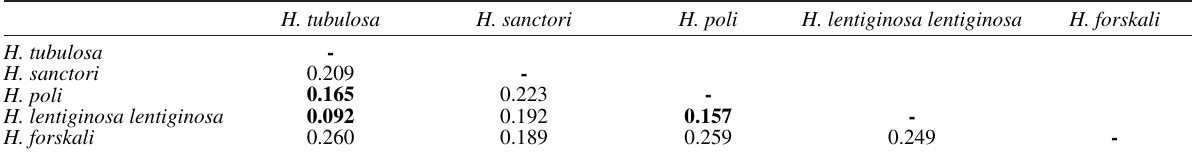
Table 2. – Genetic distances between the three Holothuria species obtained from the phylogenetic reconstruction based on the Kimura two- parameter model